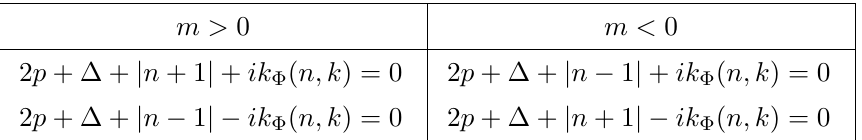
Table 7 . Conditions on the quantum numbers of spin-1 states with Brown-Henneaux boundary conditions. For m > 0 this is a subset of the states which are consistent with the chiral boundary